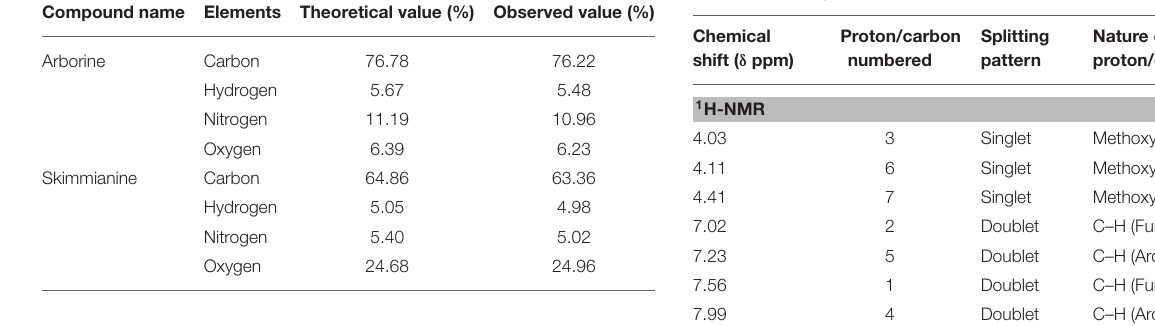
TABLE 4 | NMR ( 1 H-NMR and 13 C-NMR) spectral data of skimmianine